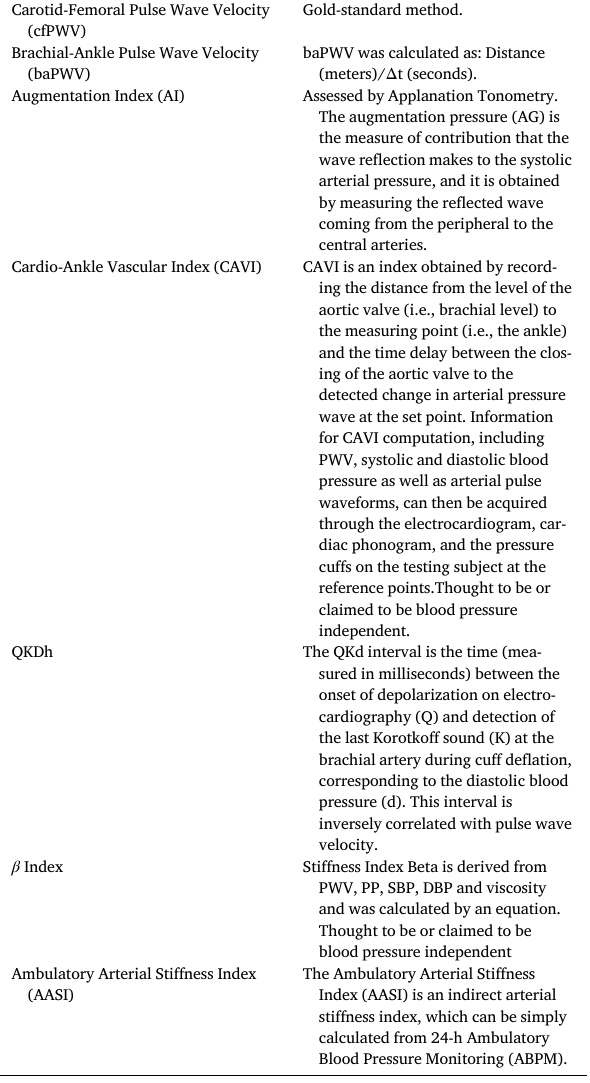
Fig. 1. Adapted from Mendes-Pinto et al